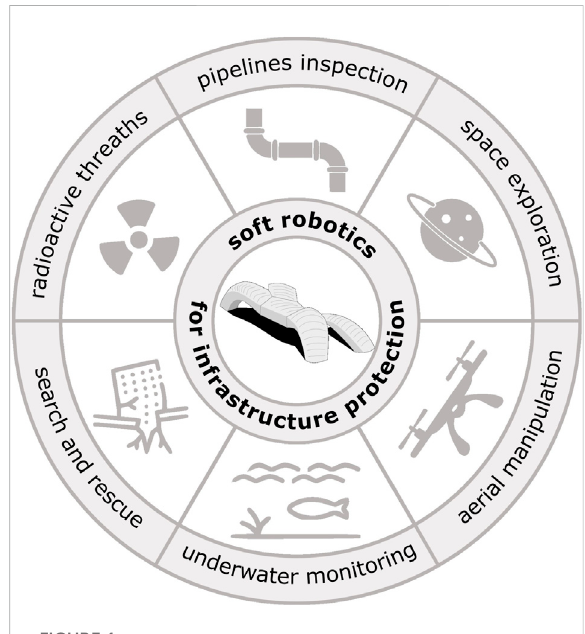
Schematic overview of possible areas of application of soft robotics in the context of the protection of critical infrastructures, such as inspection and monitoring of pipelines, rubble search and rescue, soft aerial manipulation, underwater monitoring and exploration, operations in radioactive environments and space